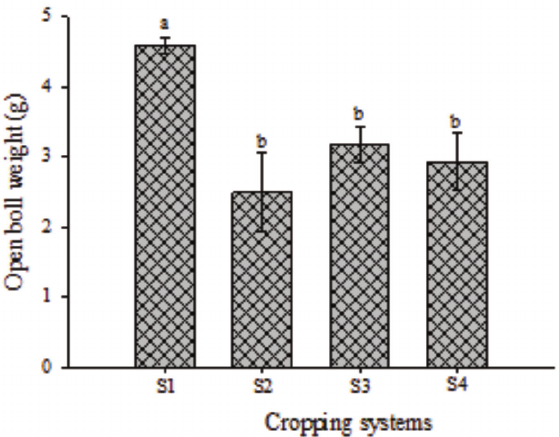
Figure 4 - Mean weight (±SE) open cotton bolls in the cropping systems of cotton (S4) or cotton intercropped with cowpea systems (S1, S2, and S3) infested by Aphis gossypii (Hemiptera: Aphididae). Each column represents the mean weight of cotton open bolls harvested in 12 plants. Error bars indicate SE. Different letters indicate differences (SNK test; P = 0.05).